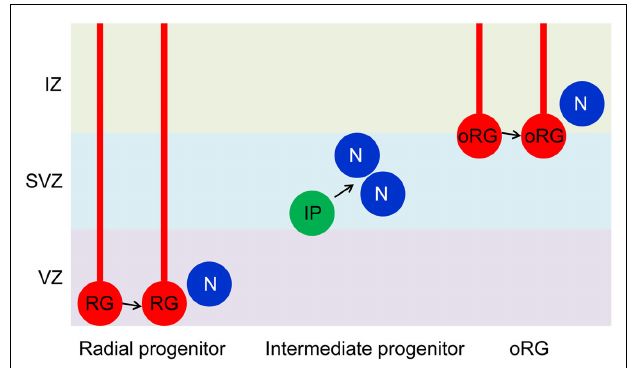
FIGURE 1 | Neural progenitors in the developing brain. Radial glial progenitors (RG) arise early in development from neuroepithelial cells.They are located in the ventricular zone (VZ) and have long radial processes that extend formVZ to the pial surface. A RG divides symmetrically to self-renew and asymmetrically to generate a daughter RG and a post-mitotic neuron or an intermediate progenitor (IP). IPs localize in the subventricular zone (SVZ) and divide symmetrically to produce neurons. There is another type of progenitors (oRG) in the superficial layer of SVZ or in the intermediate zone (IZ). Like RGs, oRGs have glial processes and can self-renew as well as generate neurons. For more information on oRG, see a recent review by Kriegstein and colleagues (Lui et al., 2011).The role of GSK-3 in regulating radial progenitors is now established. Functions related to IPs and oRGs remain to be